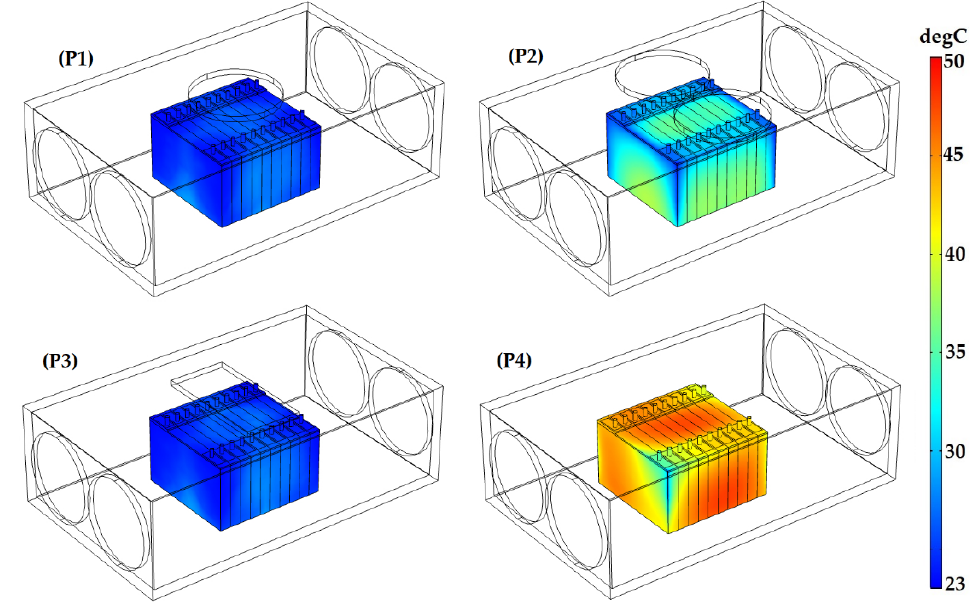
Figure 12. Temperature distribution of the LiC module regarding four inlet/outlet